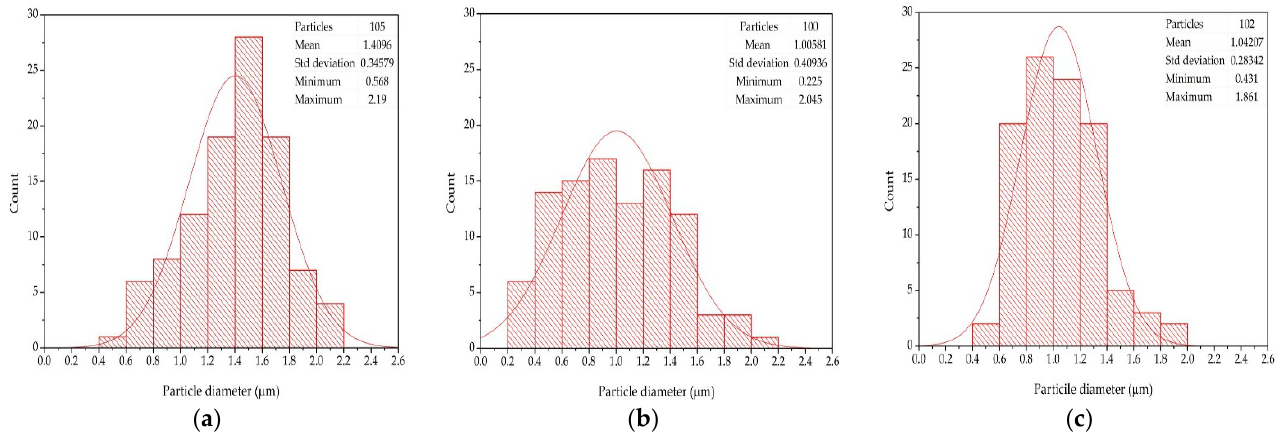
Figure 8. Particle size distribution histograms for ( a ) unprocessed PP, ( b ) first cycle of PP reprocessed using a TSE at 500 rpm, and ( c ) first cycle of PP reprocessed using a QSE at 500 rpm.